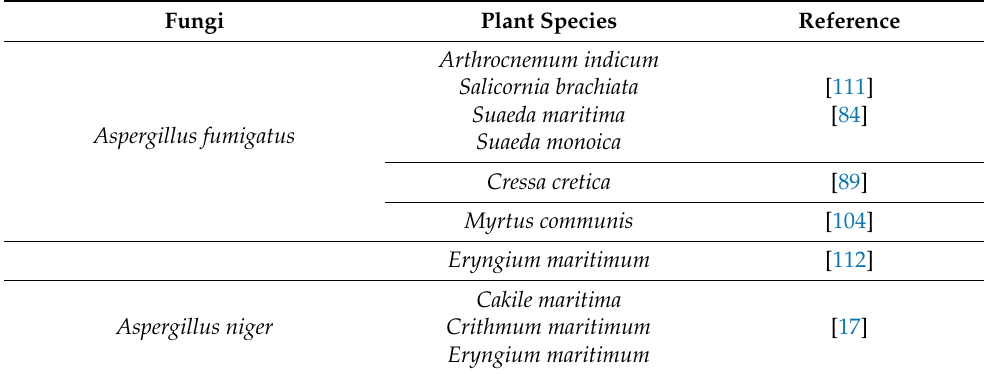
Table 4. Antifungal effects associated with extracts of halophyte